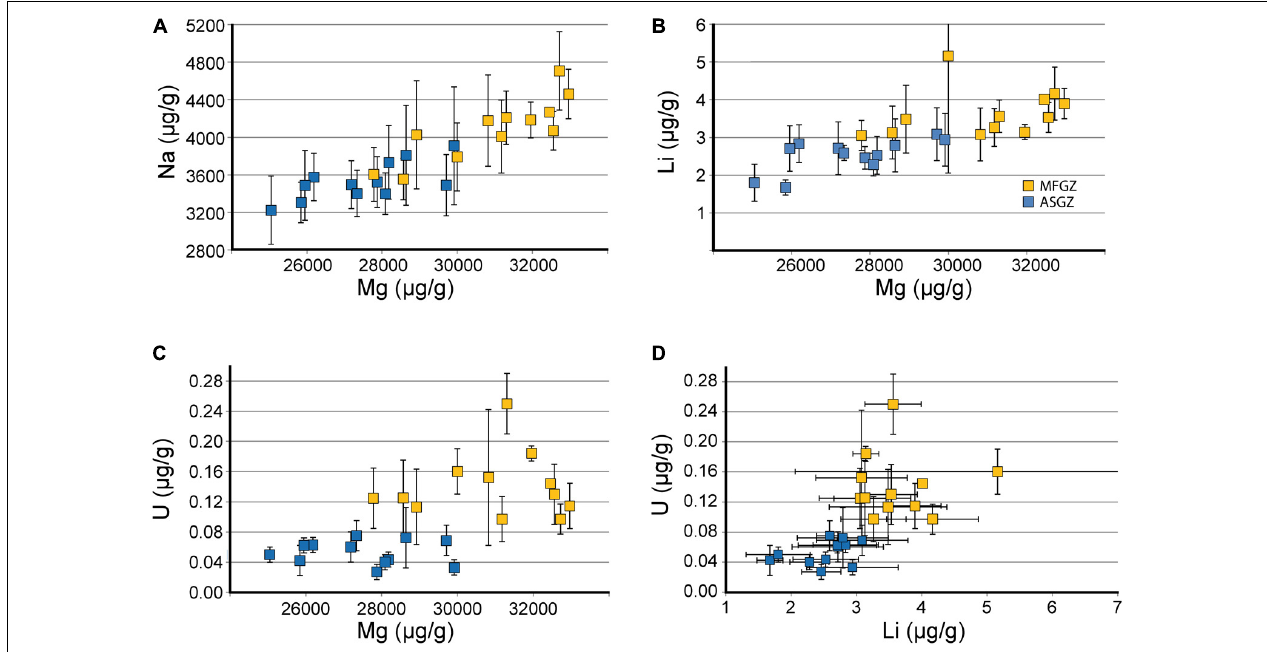
FIGURE 7 | Chemical comparison of medullar fast growing and annular slow growing zones (LA-ICPMS data). (A–C) Na, Li, and U vs. Mg. (D) U vs. Li. Mean compositions of annular slow growing zones (blue squares) and medullar fast growing zones (yellow squares) in C. rubrum , C. japonicum, C. elatius, and C. konojoi (undifferentiated). MFGZ, medullar fast growing zone; ASGZ, annular slow growing zone. Error bars correspond to standard deviations ( ± 1 σ SD) given in Supplementary Material SM1 Table 2 . Horizontal SD for magnesium have not been reported for clarity (for each dot, the mean Mg SD is about 1,500 µ